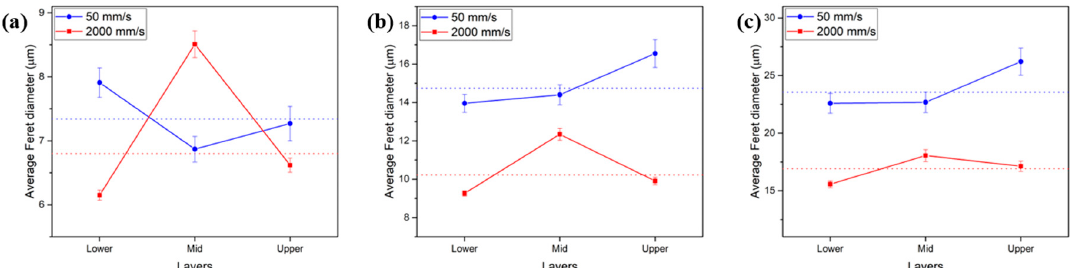
Figure 7. Average sizes of the prior austenite grains according to the regions and the scan speeds of the AM objects: ( a ) for all the detected grains, and ( b ) the grains of diameter > 5 and ( c ) > 10 µ m only (the error bars and the broken horizontal lines represent the standard errors and the average values for the whole sampled regions, respectively).